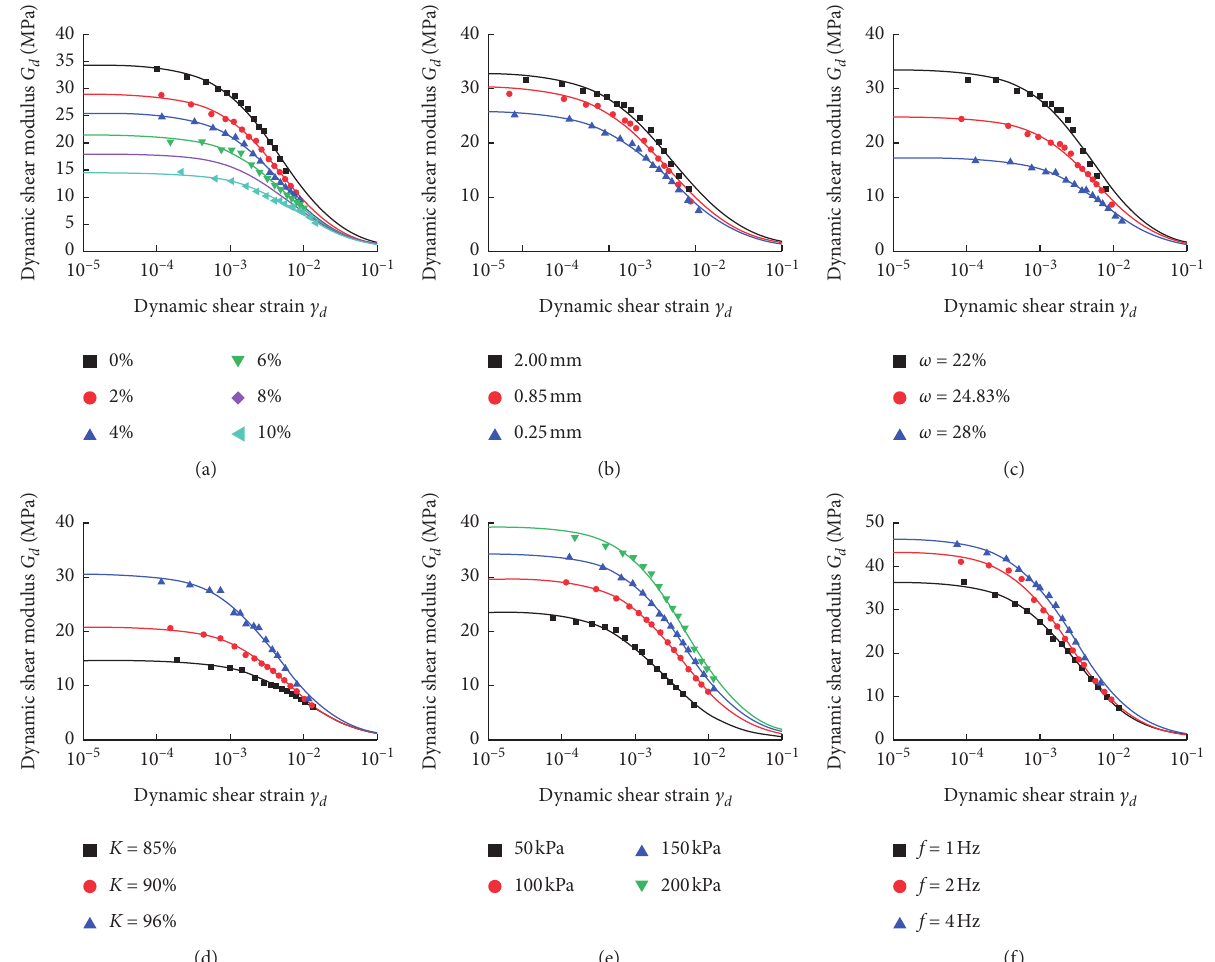
Figure 7: Dynamic shear modulus-dynamic shear strain curve of rubber-red clay. (a) Rubber powder content; (b) rubber particle size; (c) moisture content; (d) compactness; (e) confining pressure; (f) frequency.